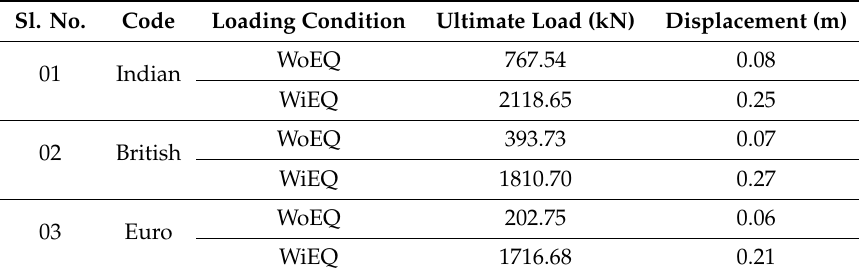
Figure 4. Pushover curves for models with earthquake loading. Table 8. (a) Table of ultimate load along with